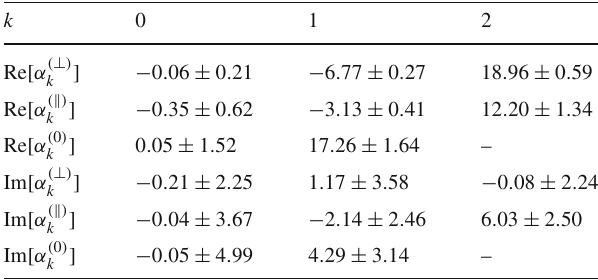
Table 1 Mean values and standard deviations (in units of 10 − 4 ) of the prior PDF for the parameters α